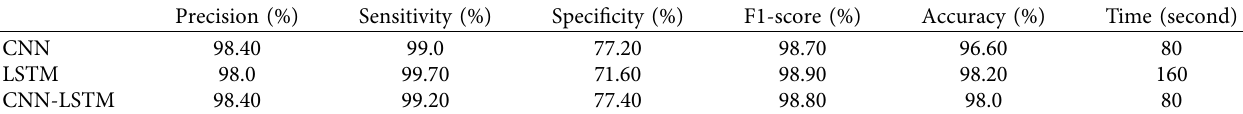
Table 8: Results of the proposed system for the validation